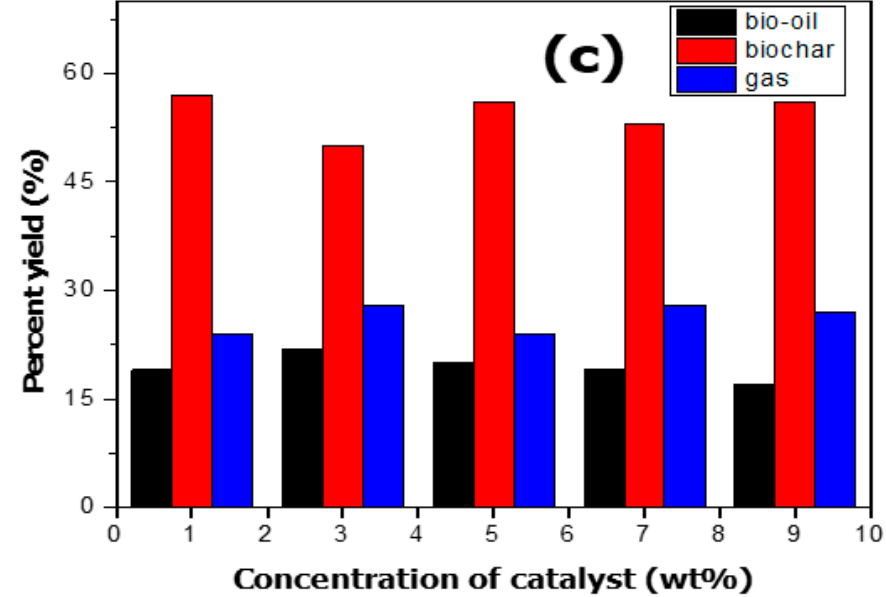
Figure 5. Product distribution from pyrolysis of lignin: ( a ) non-catalytic reaction; ( b ) catalytic reaction; and ( c ) effect of catalyst concentration.